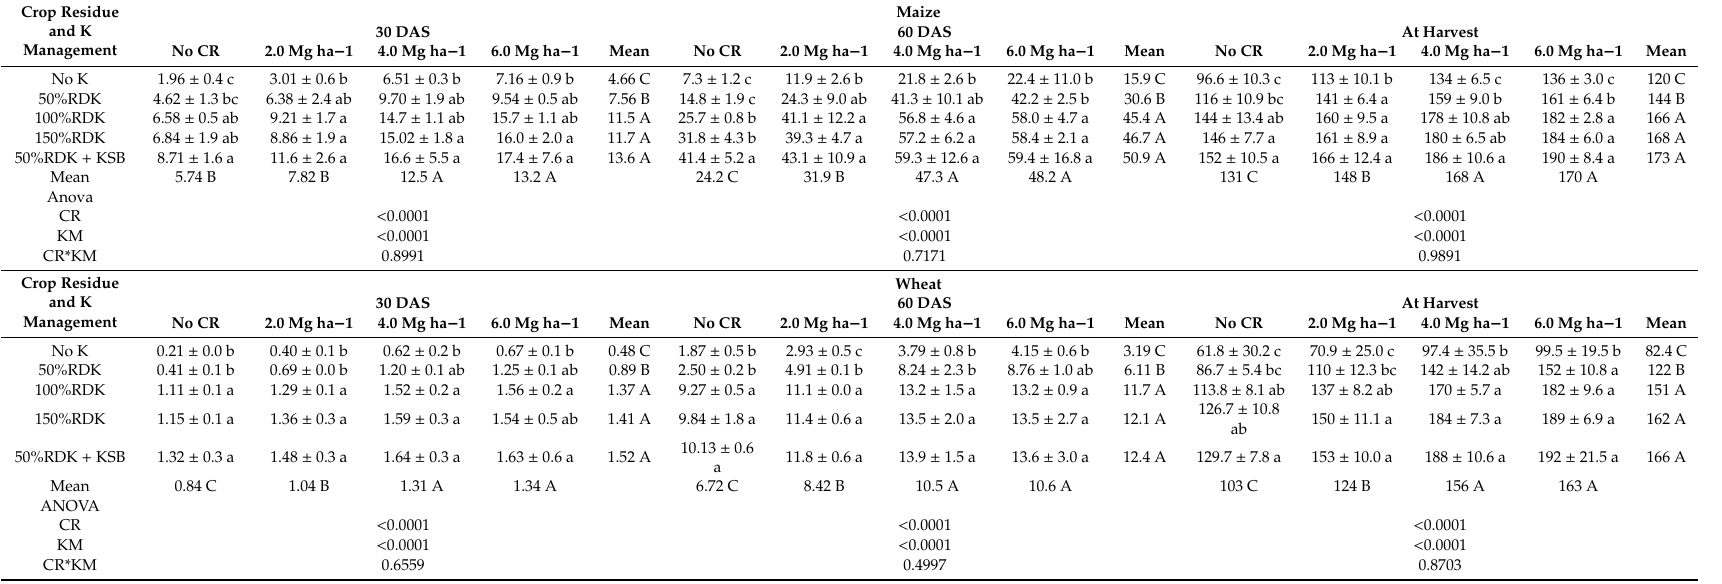
Table 2. Crop residue and potassium management practices on potassium uptake (kg ha − 1 ) of maize and wheat at di ff erent crop growth stages under zero tillage maize–wheat system (pooled data of two